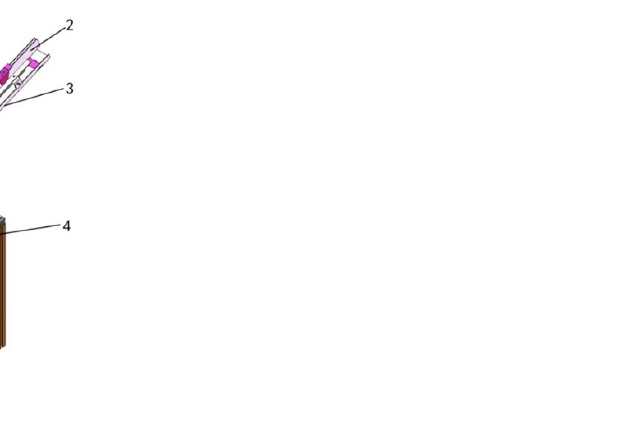
Figure 11. Structure diagram of duckbill welding robot for cotton seeder. 1. Girdle feeding mecha- nism; 2. static duckbill feeding mechanism; 3. hinge feeding mechanism; 4. support platform; 5. welding fixture; 6. welding actuator. 5. welding fixture; 6. welding actuator.